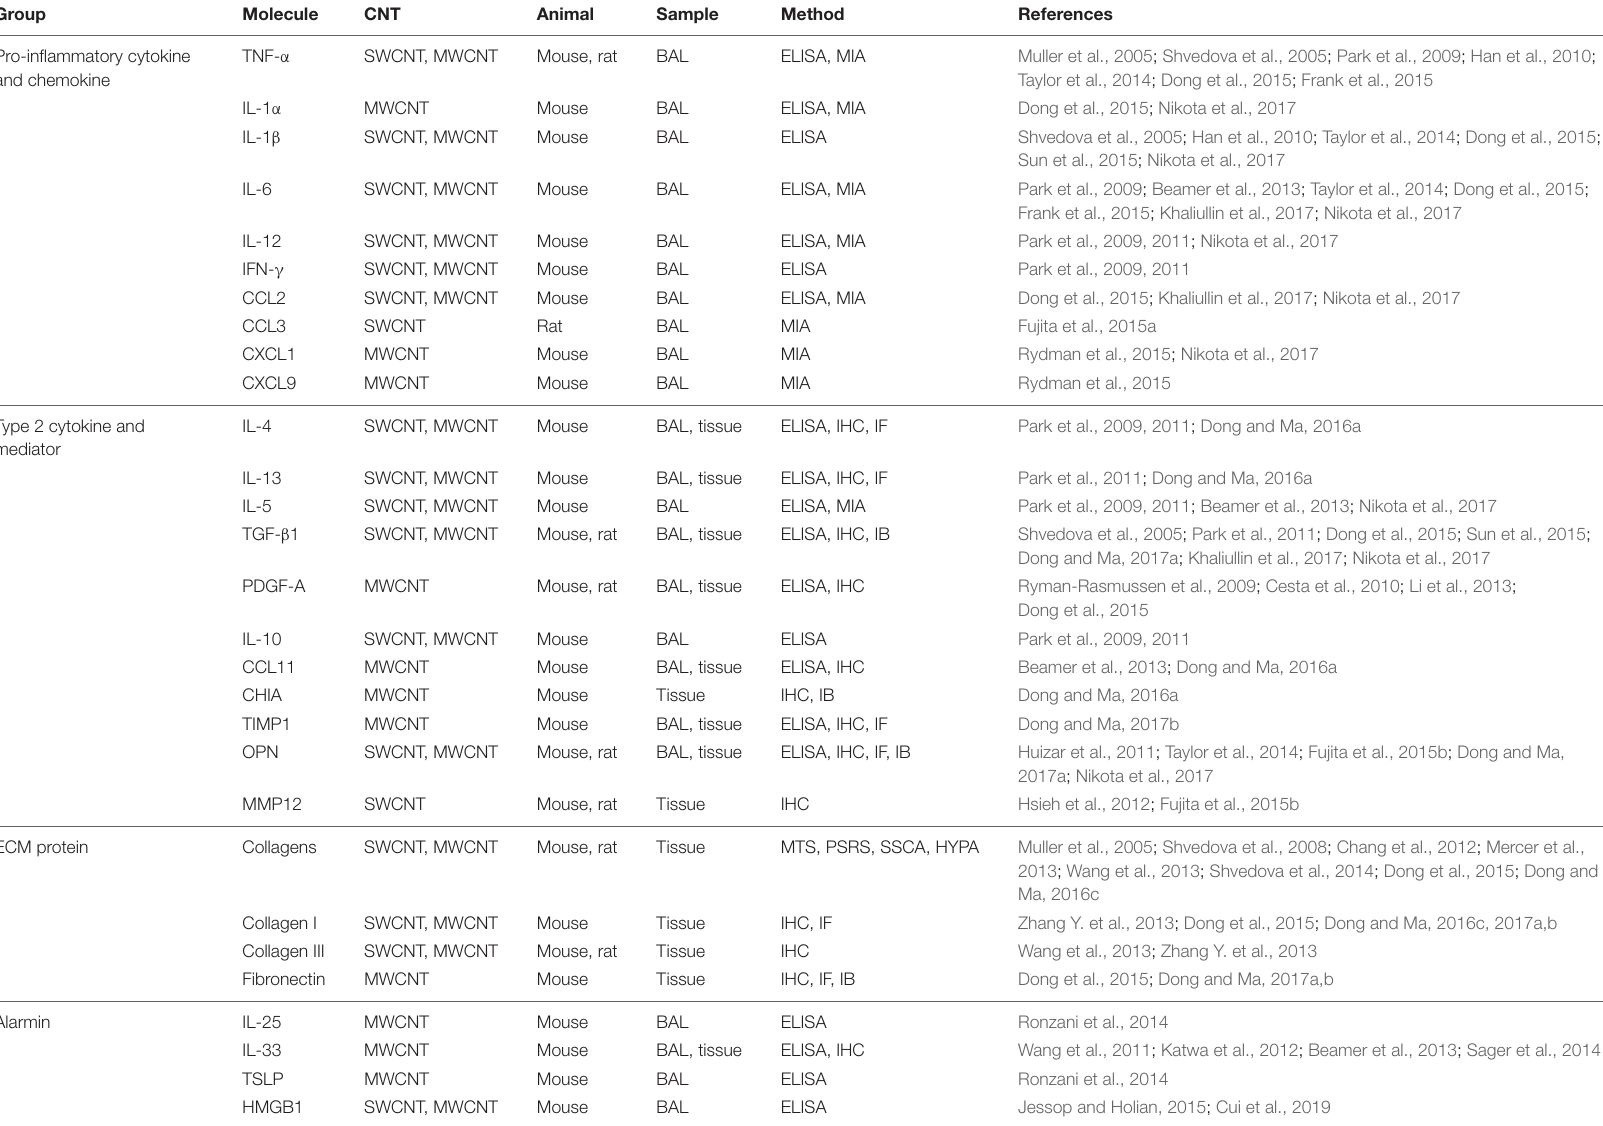
TABLE 1 | CNT-induced pathological factors in rodent lungs. Group